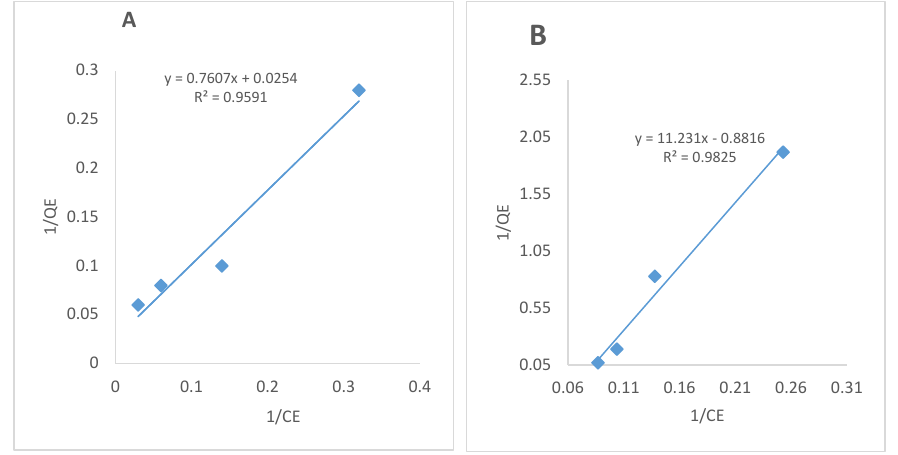
Figure 18. The Langmuir Isotherm Model adsorption for Pb(II) onto ( A ) adsorbent 1 and ( B ) adsorbent 2 . (Experimental conditions: dosage = 0.015 g (adsorbent 1 ) and 0.1 (adsorbent 2 ) per 50 mL; T = 25 ± 1 °C; contact time = 60 min.; pH = 6.5 ± for Pb(II). Processes 2020 , 8 , 246